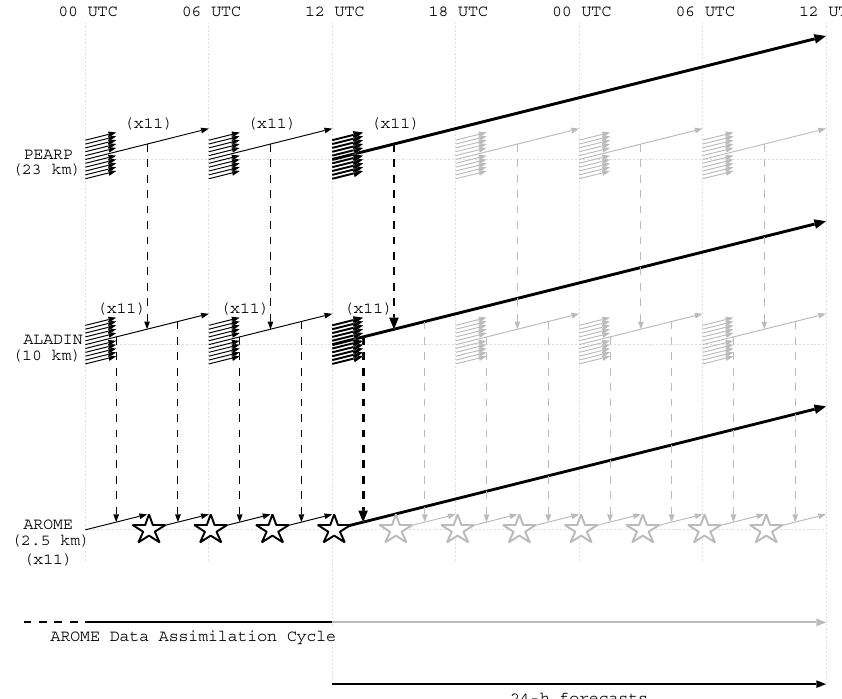
Fig. 1. The E3 ensemble experiment. Each nested model run is schematised along one row. Each plain (thick) arrow indicates the behavior of the eleven ensemble members (x11) short (long) runs. Their coupling along time is figured by the vertical dashed arrows. Each PEARP member provides LBCs to one ALADIN downscaling forecast, itself providing LBCs to one AROME data assimilation cycle with data analysis using randomly perturbed observations (stars) every 3h. Each day, 24-h AROME forecasts are run at 12:00 UTC. The continuing assimilation cycles after 12:00 UTC are shown in light